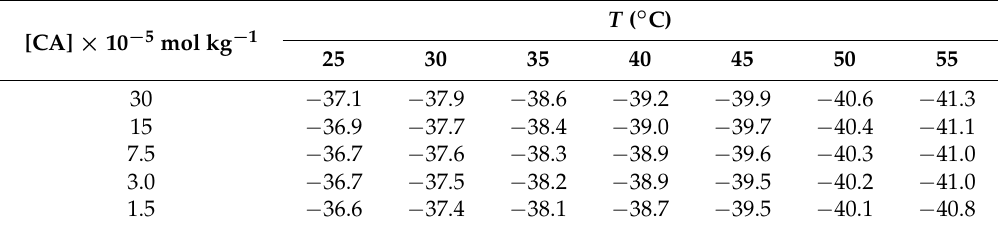
Table 2. ∆ G 0 m values (kJ mol −1 ) for SDS–CA micelles as obtained by substituting CMC and β values into Equation (3). The uncertainly values are below 10%.